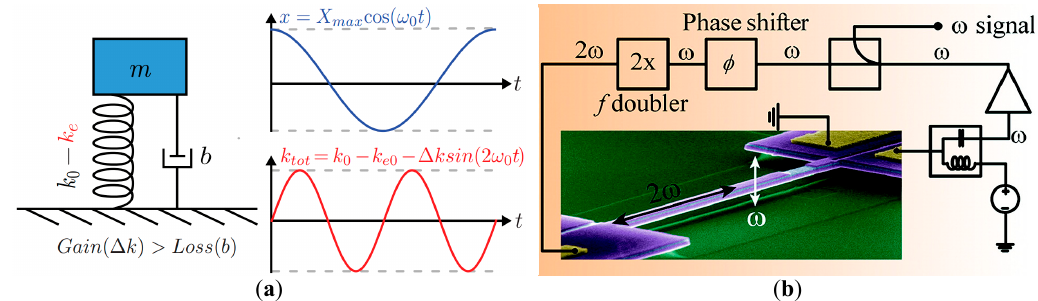
Figure 32 . ( a ) Parametric pumping of a MEMS electrostatic resonator [223]; © 2014 IEEE. Reprinted with permission from A micromechanical parametric oscillator for frequency division and phase noise reduction by Rocheleau in the Proceedings of International Conference on Micro Electro Mechanical Syst., 2014; and ( b ) a typical parametric oscillator loop used with a nanoscale resonant beam [261]. Reproduced with permission from Villanueva et al., Nano Lett. ; published by American Chemical Society, 2011.